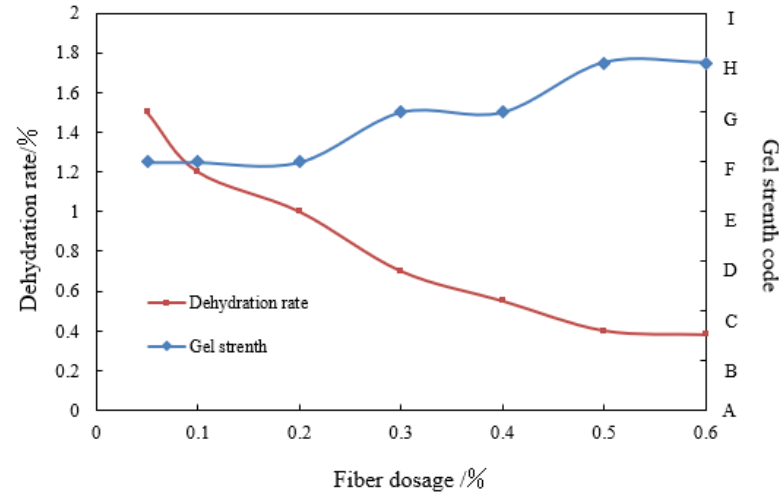
Figure 2. Optimization experiment of stabilizer dosage.